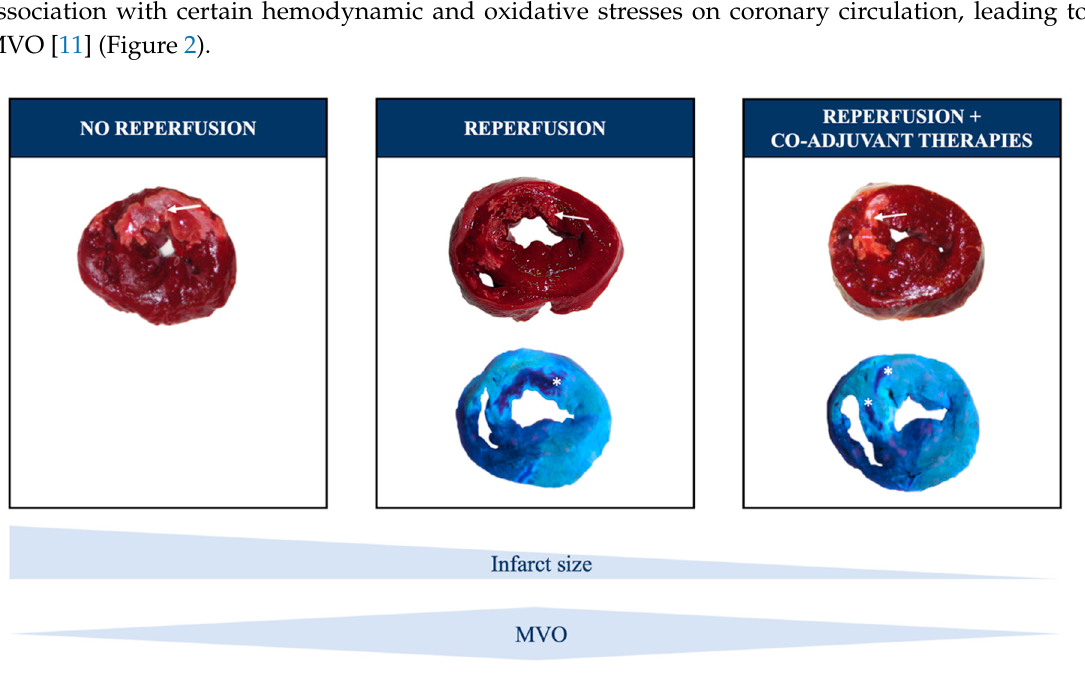
Figure 2. Coronary reperfusion and microvascular obstruction (MVO). The absence of coronary reperfusion leads to transmural infarction (left panel). A complete and prompt reperfusion of the culprit artery, ideally by percutaneous coronary intervention, reduces infarct size but may imply a certain ischemia-reperfusion injury, including MVO (central panel). Hopefully, future co-adjuvant therapies beyond reperfusion will further diminish infarct size and MVO extent, and consequently, will improve patient outcomes (right panel). Arrows point at areas with infarction and asterisks at regions with MVO.